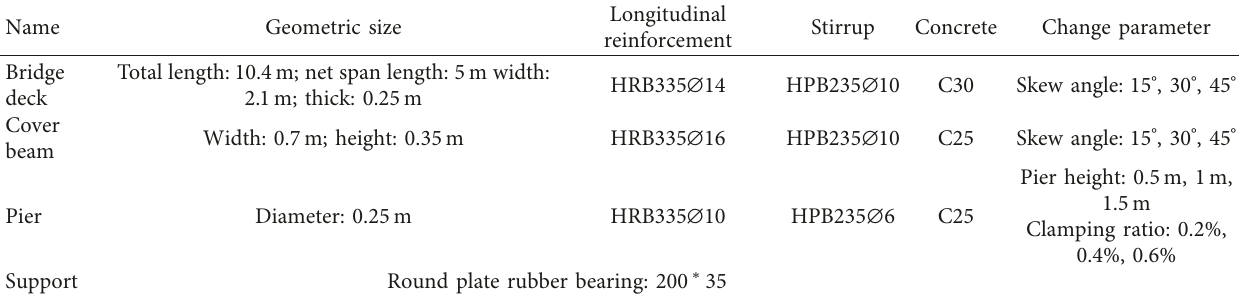
Table 1: Geometrical dimensions and material parameters.